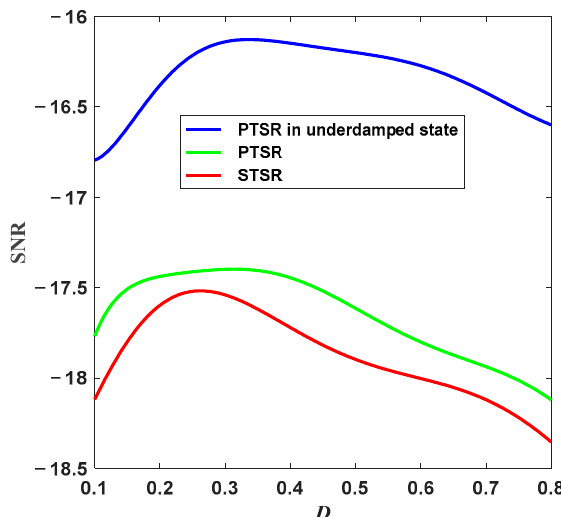
Figure 2. The SNR curve of the output signal.